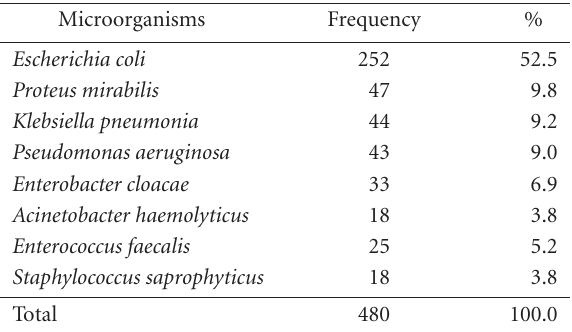
Table 1. Frequency of microorganisms isolated from 480 outpa- tients positive urine cultures. Figures reflect the number of the